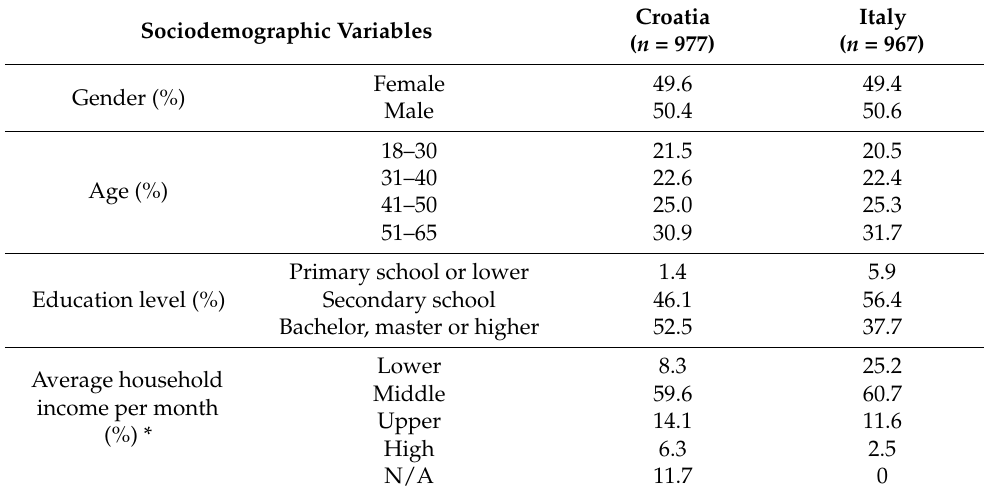
Table 1. Sociodemographic characteristics of study participants in Croatia and Italy.